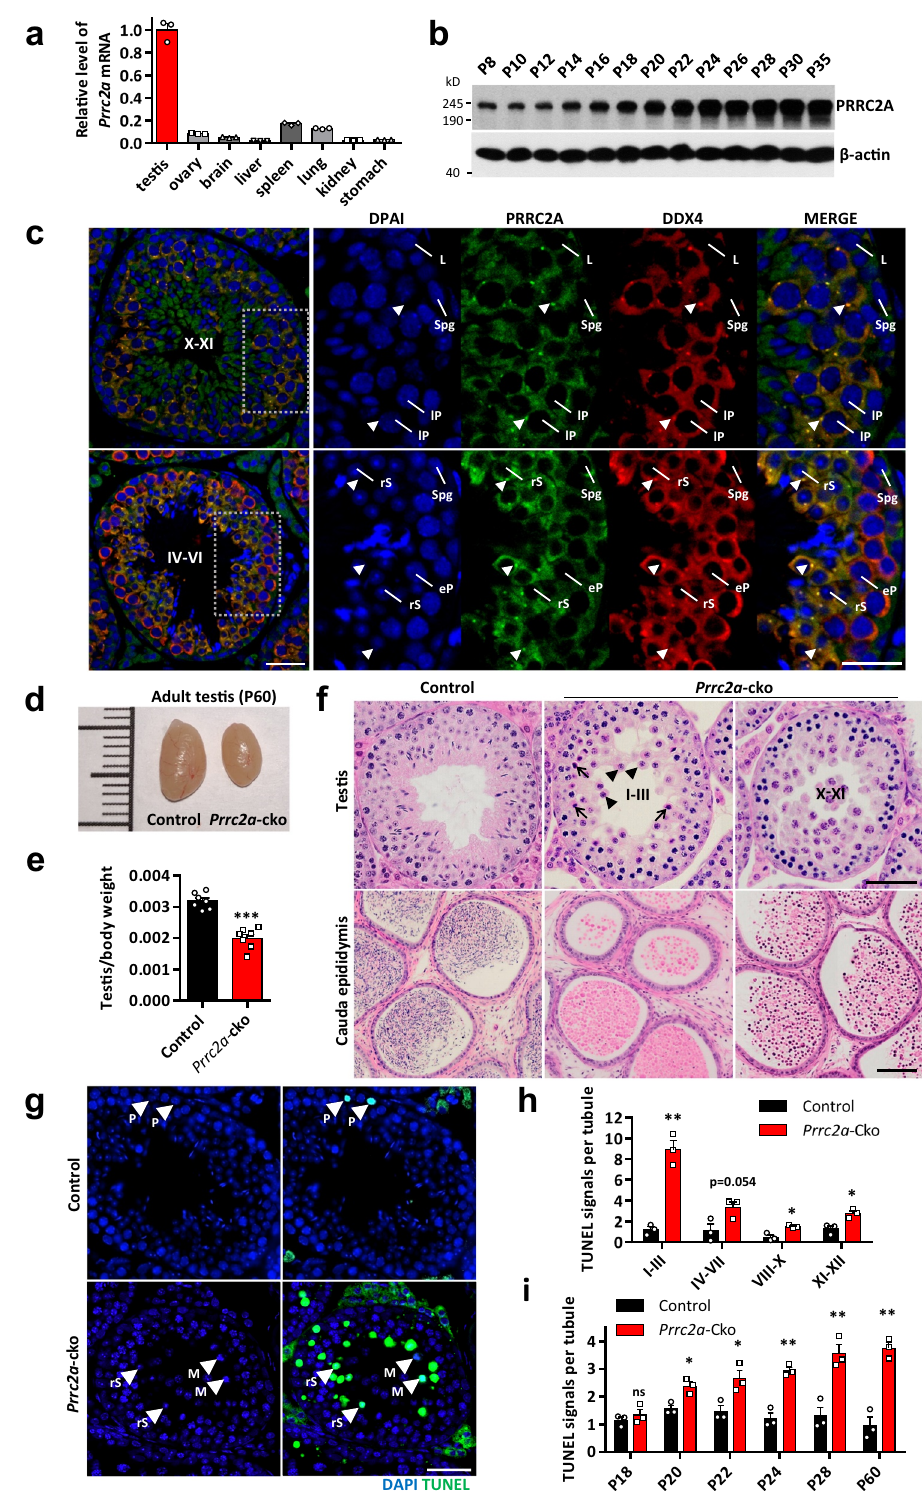
spreads of meiotic prophase spermatocytes (Fig. 2a). PRRC2A-null prophase spermatocytes develop normally through the leptotene, zygotene, pachytene, diplotene stages, and the proportion of each typeof spermatocytes was similartocontrols(SupplementaryFig.4b). γ H2AX signals in PRRC2A-null spermatocytes were distributed around